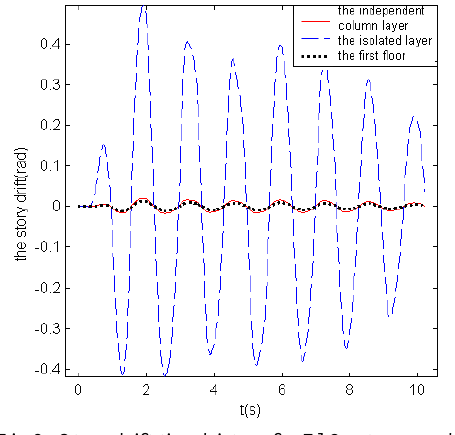
Fig.6a Story drift time history for El Centro record